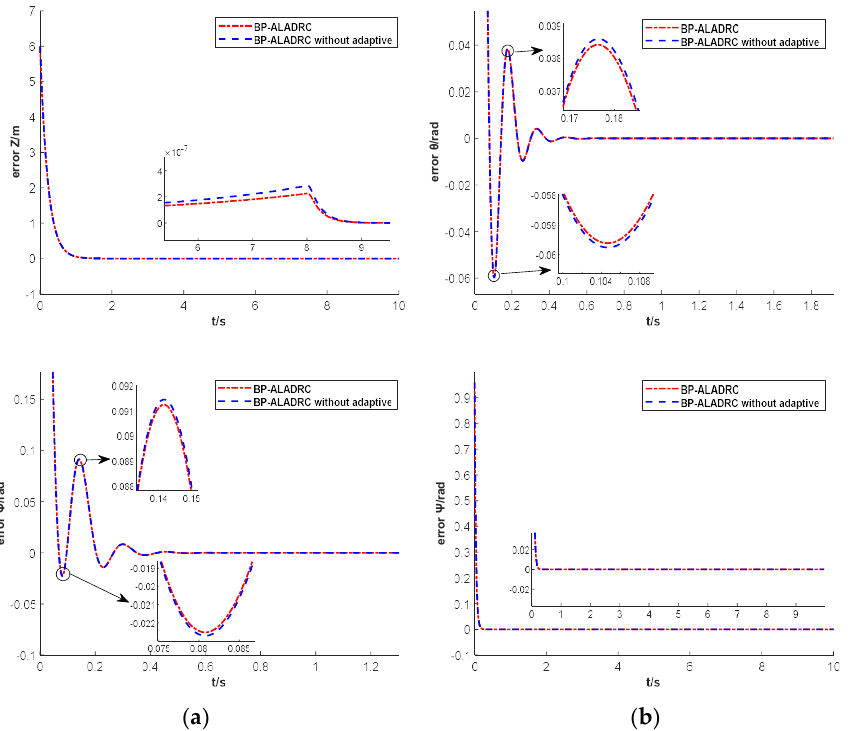
Figure 12. System output errors: (a) Altitude and Roll angle output errors; (b) Pitch and Yaw angle output errors.